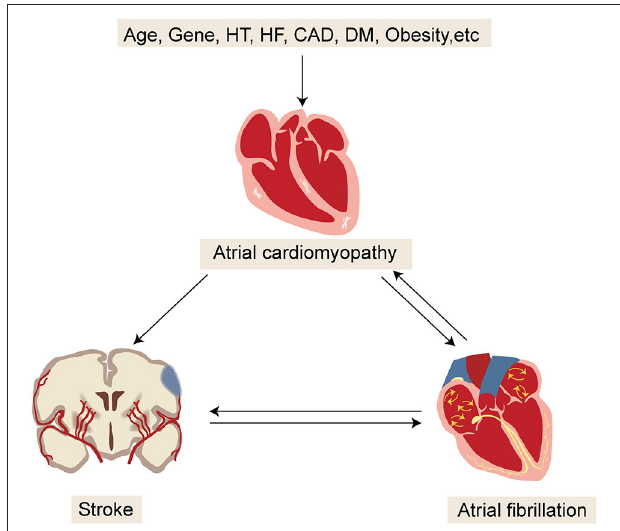
FIGURE 4 | Updated model for better understanding the mechanisms of embolic stroke. HT, hypertension; HF, heart failure; CAD, coronary artery disease; DM, diabetic